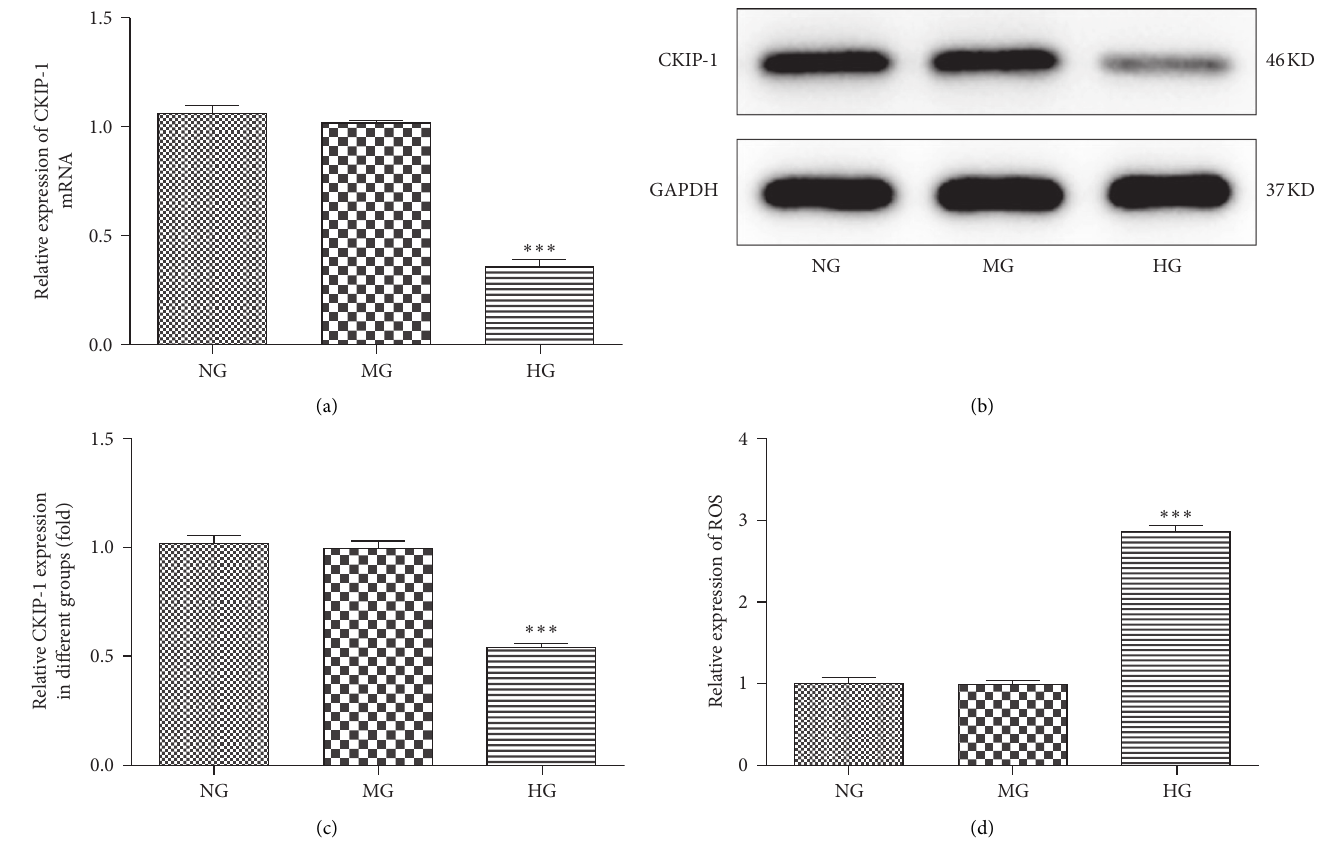
Figure 1: CKIP-1 expression is reduced in high glucose-triggered ARPE-19 cells. The mRNA (a) and protein (b) and (c) expressions of CKIP-1 were detected by RT-PCR and Western blots, respectively. (d) ROS generation was measured by the ROS kit. ∗∗∗ p < 0.001 vs. NG. NG, normal glucose (5.5mM); MG, mannitol (20mM); HG, high glucose